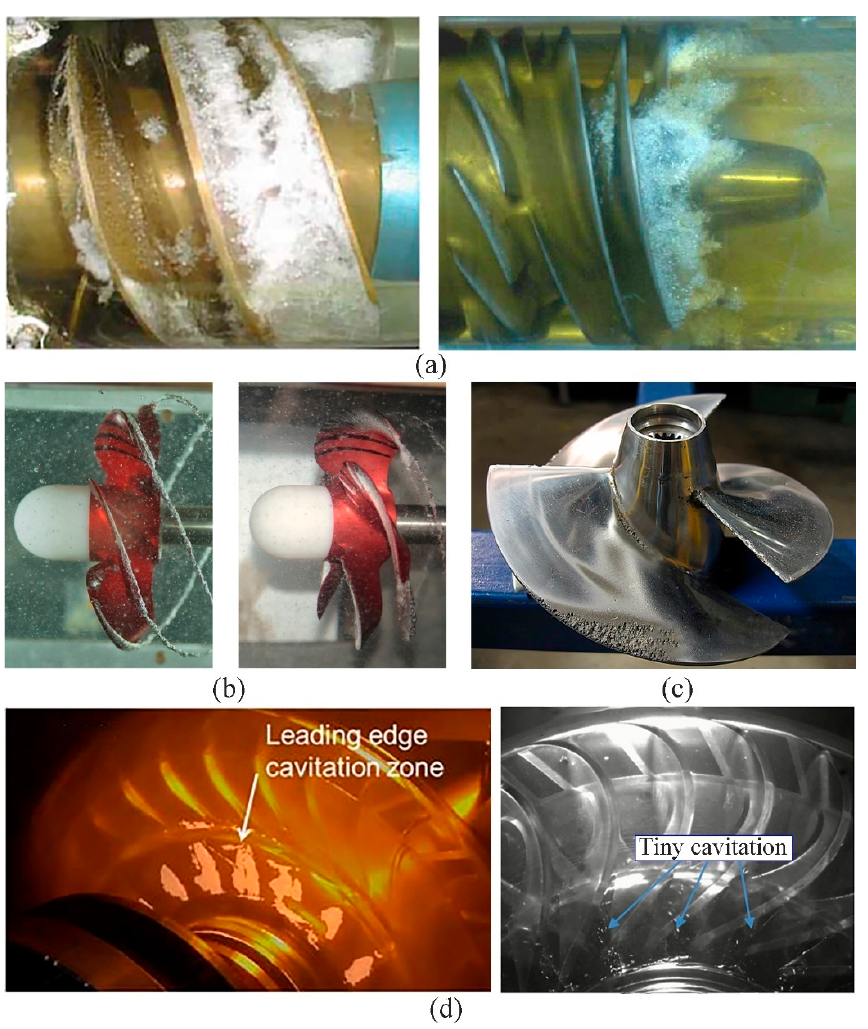
Figure 1. Cavitation in typical turbomachines. ( a ) cavitation generated in inducer, ( b ) cavitation in tip vortices and marine propeller blades, ( c ) cavitation damage of a marine propeller blade, and ( d ) cavitation generated in hydrodynamic torque converter.